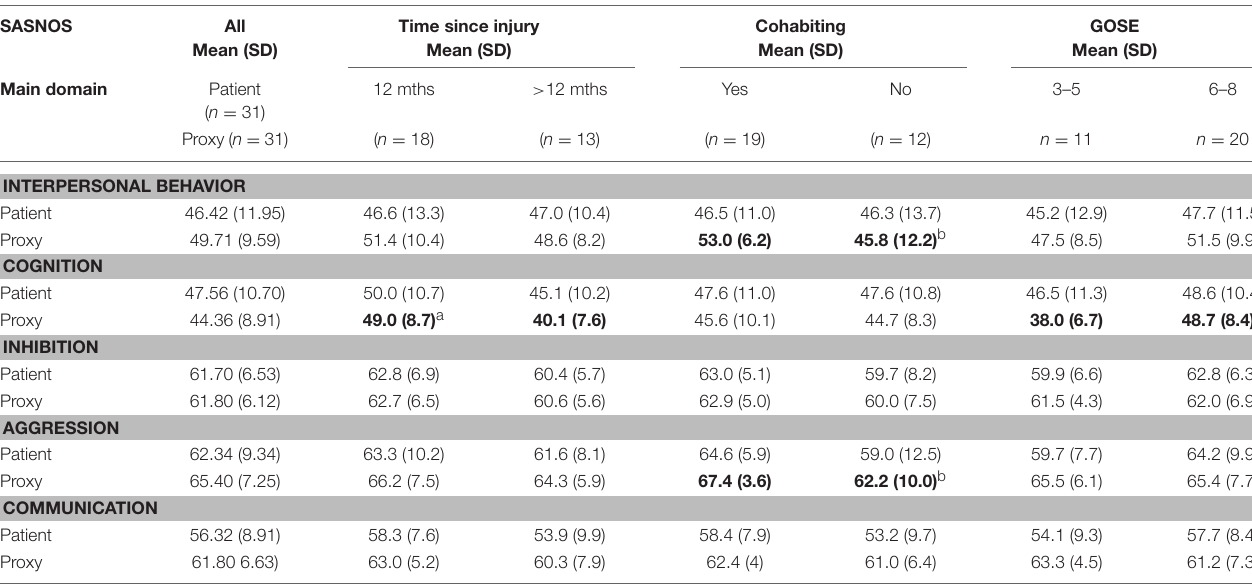
TABLE 5 | SASNOS domains by proxy and patient characteristics.